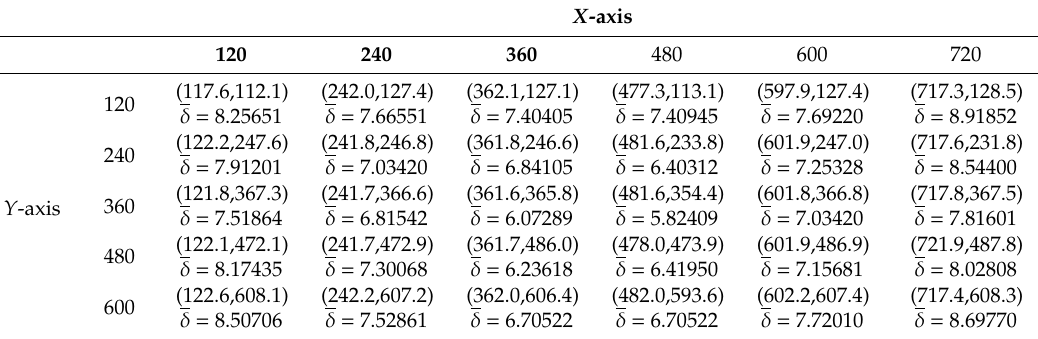
Table 2. Camera localization average error at each coordinate